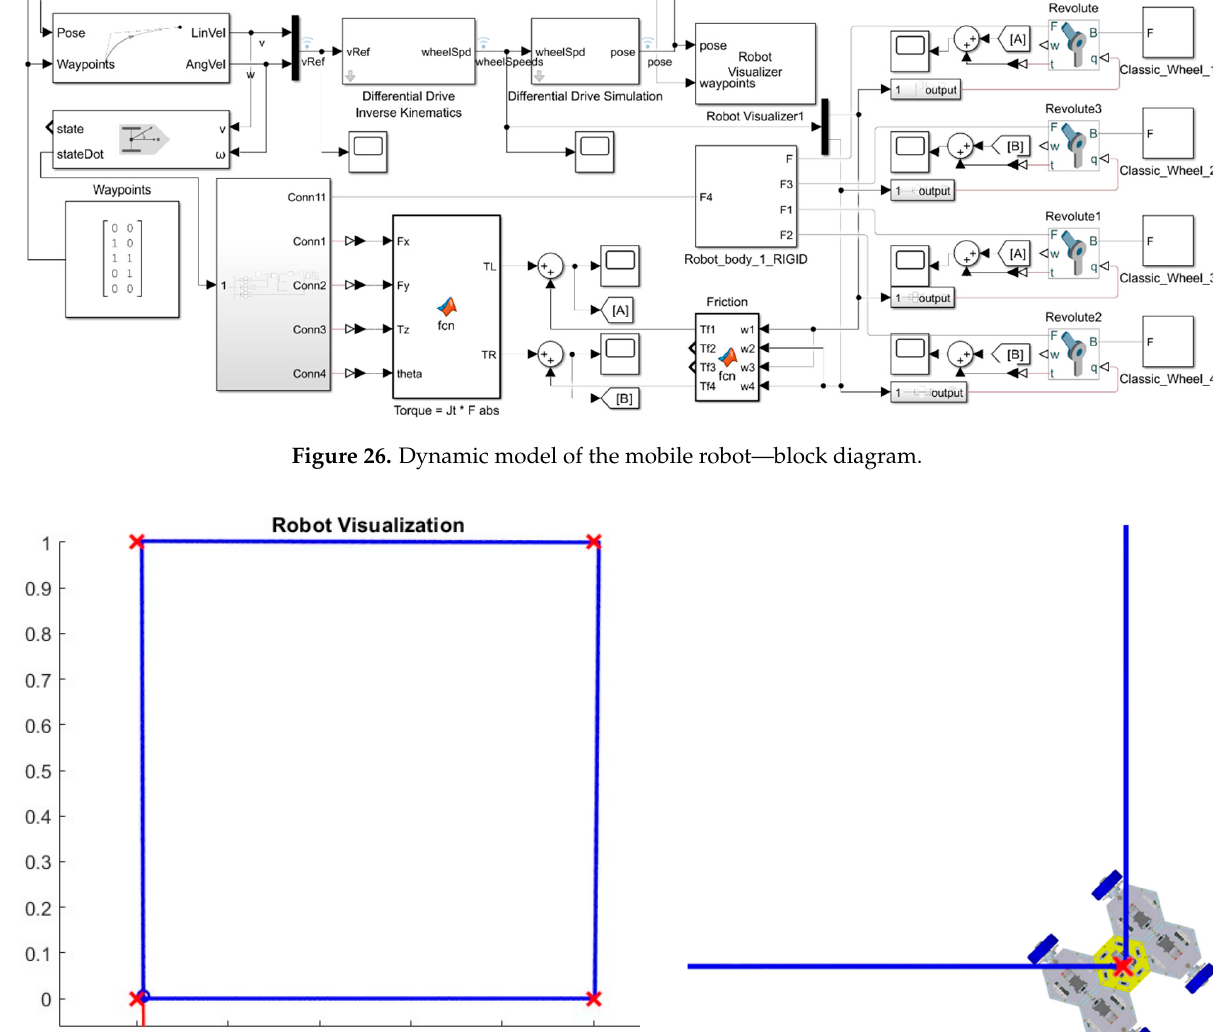
Figure 26. Dynamic model of the mobile robot—block diagram.